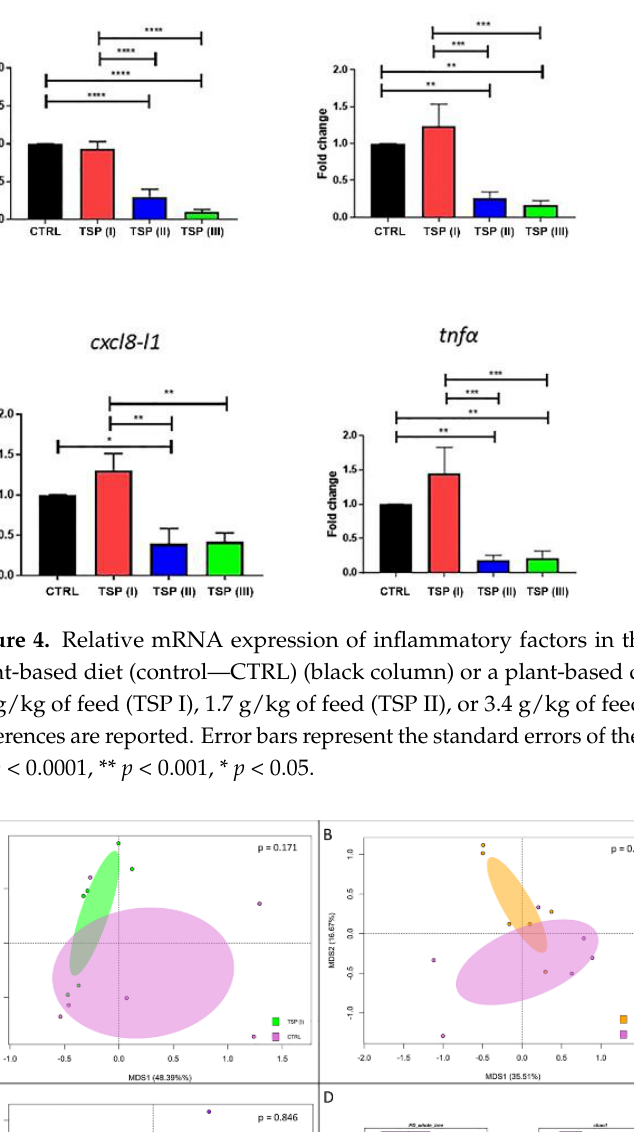
9 of 18 Figure 3. COX2 immunostaining in the intestines of ( A ) zebrafish fed the control diet; ( B ) TSP I, zebrafish fed the control diet supplemented with TSP at 0.9 g/kg of feed; ( C ) TSP II, zebrafish fed the control diet supplemented with TSP at 1.7 g/kg of feed; and ( D ) TSP III, zebrafish fed a diet enriched with TSP at 3.4 g/kg of feed . Scale bar: 100 μm. Arrows indicate COX2 expression on the apical side of epithelial cells. 3.4. Inflammatory Factor Analysis